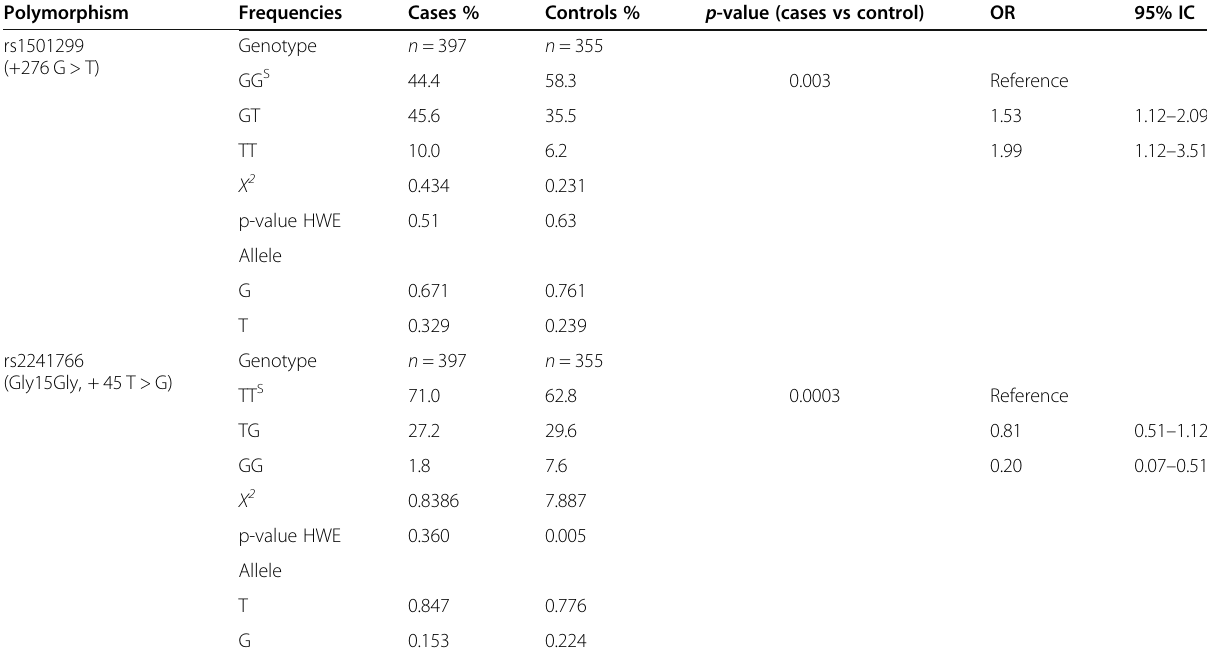
Table 3 Frequencies of adiponectin polymorphism in Mexican Women wihout adjusted by age and BMI Polymorphism